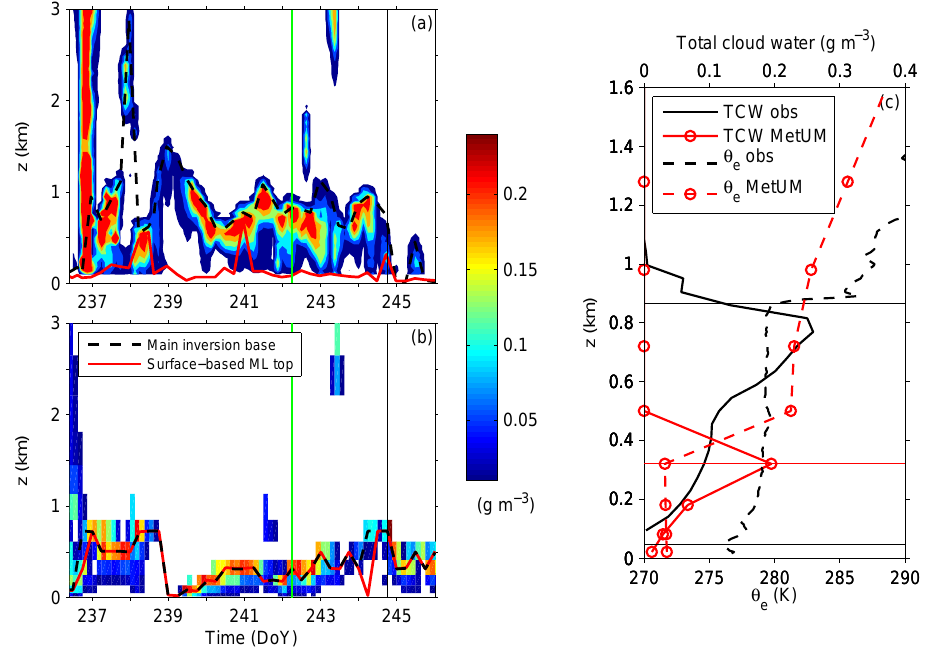
Fig. 6. Total cloud water concentrations: (a) 3-hourly averaged observations and (b) 3-hourly operational diagnostics from the MetUM. The black dashed line shows the base of the main inversion and the red line shows the top of the surface-based mixed layer. The vertical black line represents the start of the 5th regime and the vertical green line indicates the time of the data used in (c) . Panel (c) shows the observed (black lines) and modelled (red lines) total cloud water content and equivalent potential temperature ( θ e ) at DoY 242.25. The horizontal lines show the heights of the main inversion base and of the surface-based mixed layer